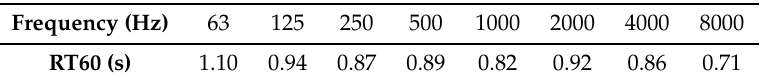
Figure 6. Layout of the practical test setup with five sensor nodes A, B, C, D and E. Table 2. RT 60 Test setup.